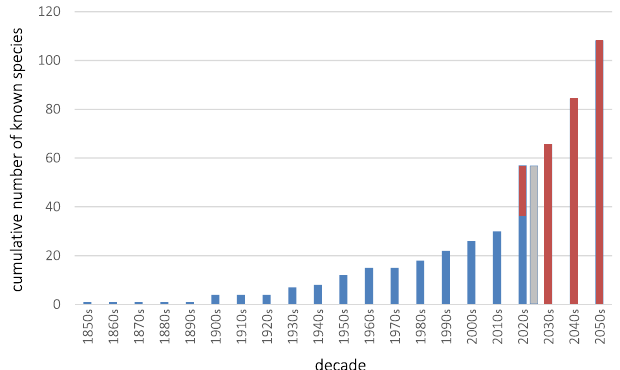
Figure 3. Cumulative species richness of Pseudechiniscus since the description of the nominal Pseudechiniscus suillus with predicted species numbers until 2059. Red bars indicate the predicted number of species in the future decades. The decade 2020–2029 is the only one with two bars: the first bar signifies the number of described species (blue portion) + the predicted number of species (red portion), whereas the second (grey) bar signifies the total number of known and undescribed species that were uncovered in this study. See sections Remarks in the Results for the taxonomy and our additional remarks on the validity of some species, echoing Tumanov 22 and Grobys et al. 23 findings.